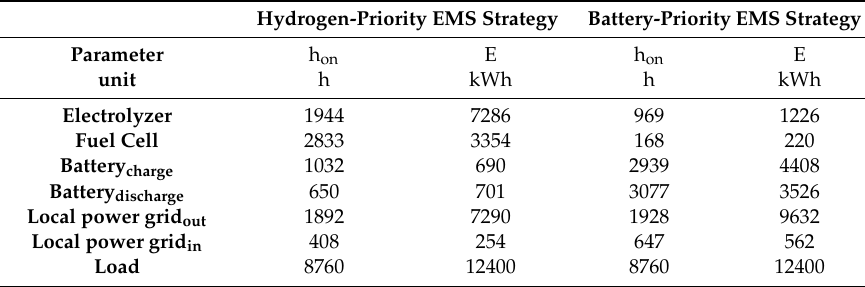
Table 6. Comparison of simulation results 2. Energy